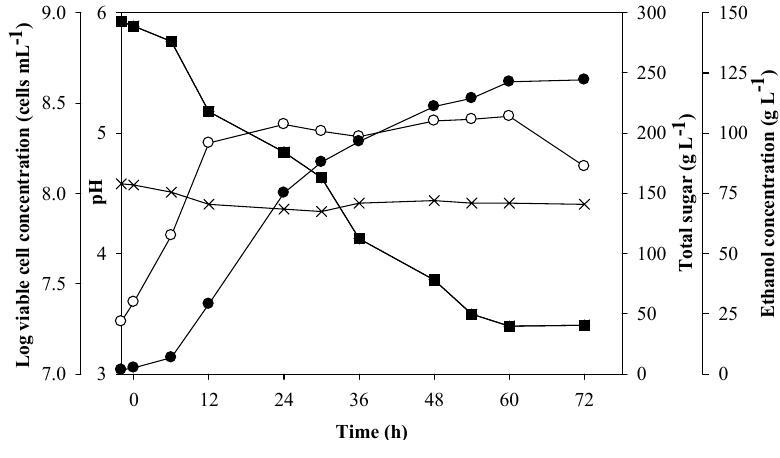
Figure 3. Batch ethanol fermentation of Run 1 (agitation rate, 100 rpm; aeration rate, 0.5 vvm and aeration timing, 2 h) from the sweet sorghum juice containing 9 g L − 1 of yeast extract ( ○ = log viable cell concentration, × = pH, (cid:132) = total sugar and ● = ethanol